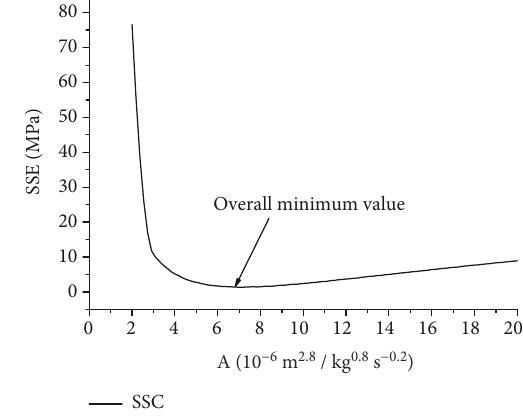
Figure 5: Minimum SSE values at di ff erent constant A values.